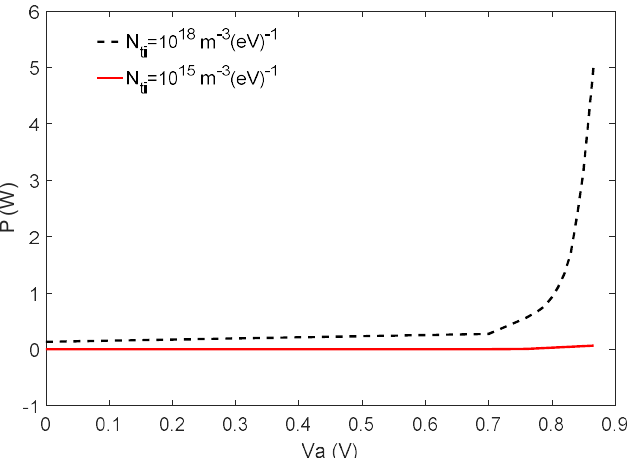
Figure 8. The total heat generation rate ( P in W) due to the non-radiative recombination through the active layer as a function of the applied voltage V a